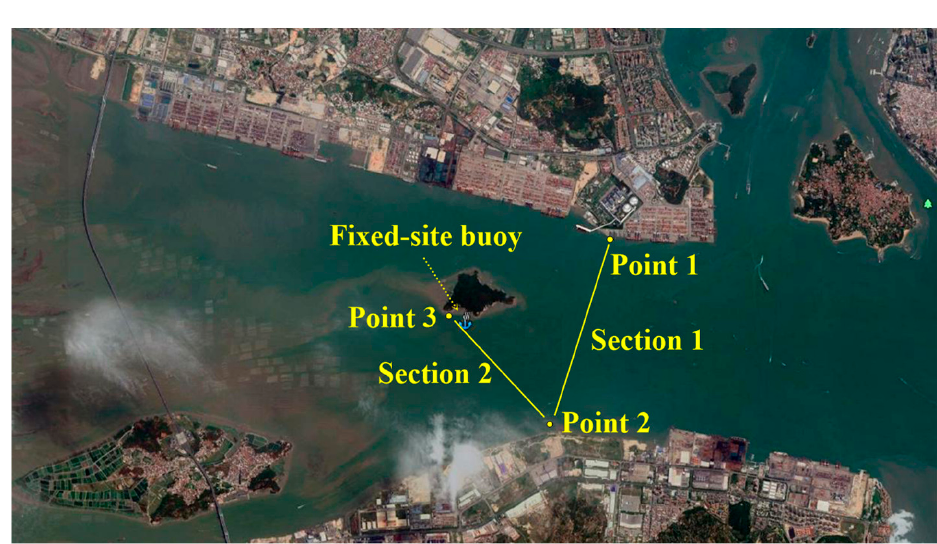
Figure 1. JLR–XMB in the study area.